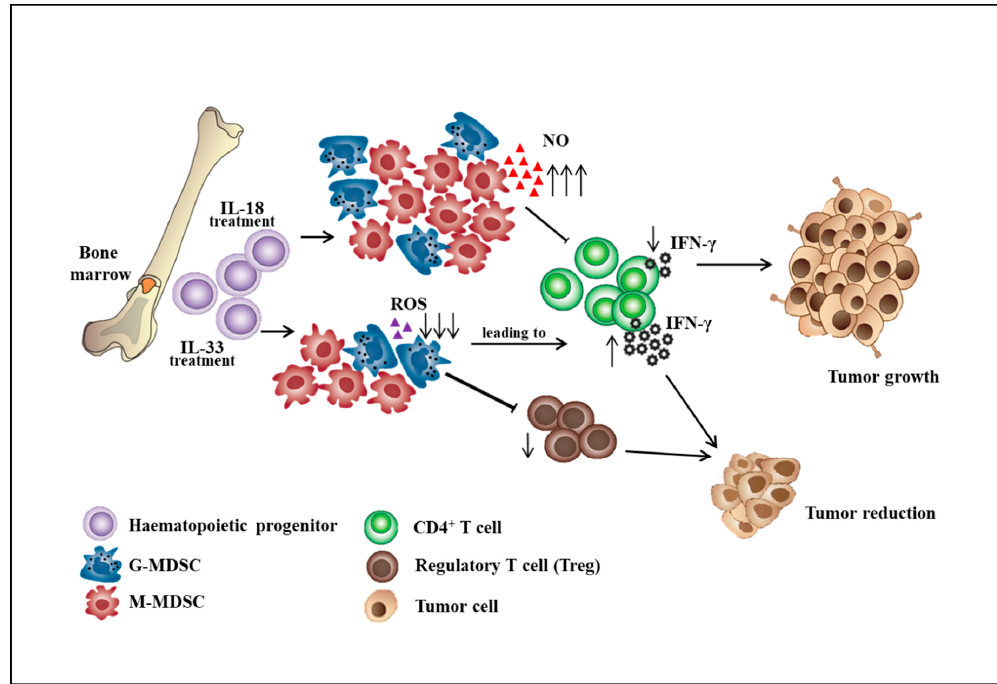
Figure 1. The roles of interleukin-18 and interleukin-33 on the differentiation of bone marrow cells into myeloid-derived suppressor cell subsets. ↑ : increase level, ↓ : decrease level.